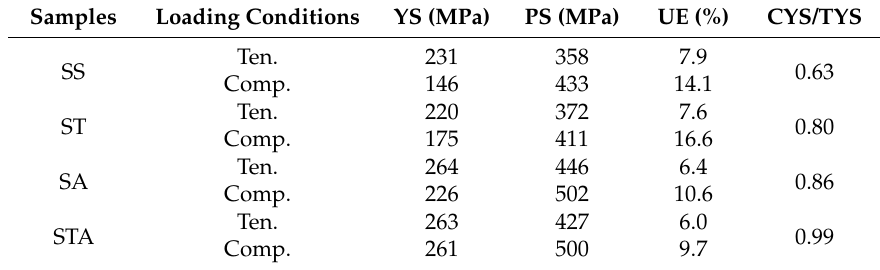
Figure 7. True stress and true strain curves of various samples: ( a ) tension and ( b ) compression. Table 3. Yield strength (YS), peak strength (PS), uniform elongation (UE) and CYS/TYS of various